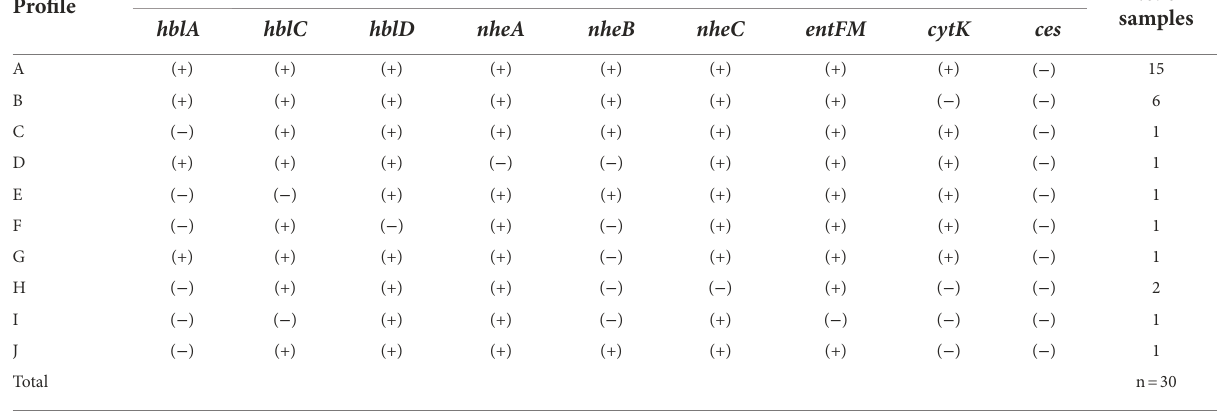
TABLE 5 Enterotoxin gene profiles of Bacillus cereus group isolates.